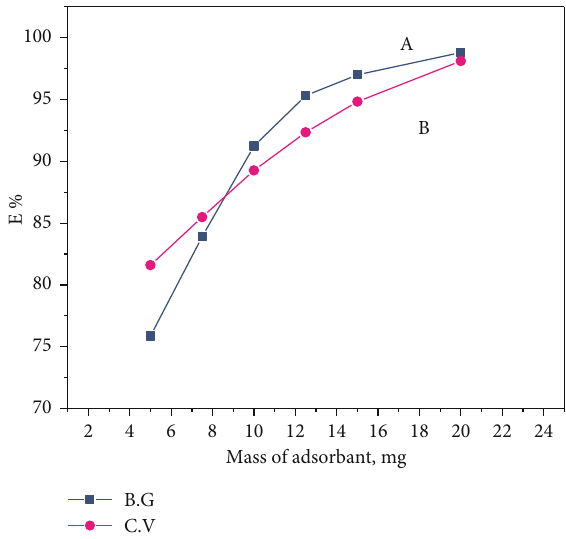
Figure 8: Impact of mass of the binary P3NT/30%AgTiO the adsorption percentage of dye species B.G. (a) and C.V. (b) from aqueous media with stirring time of 75 minutes at 22 ° C temperature settings.